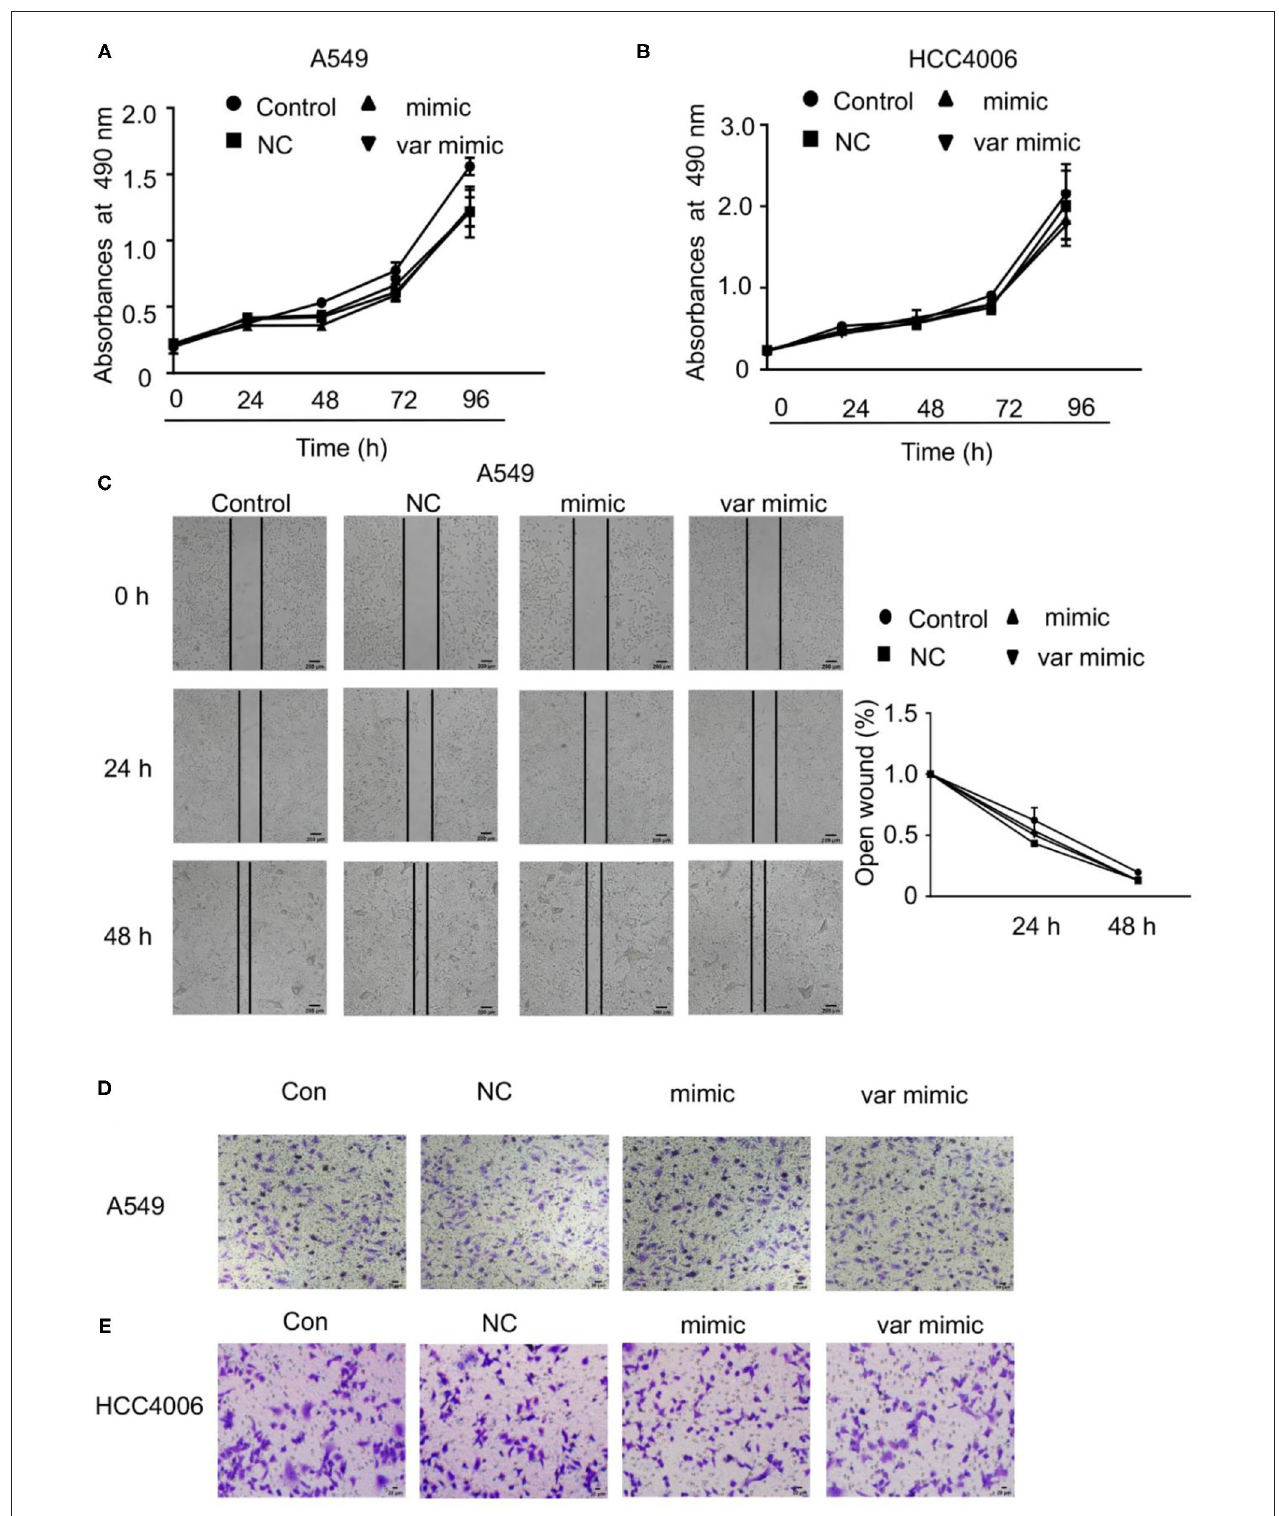
FIGURE 5 | Effect of miR-608 on the proliferation and metastasis of NSCLC cells. Cell proliferation was examined by MTT assay in A549 (A) and HCC4006 (B) cells transfected with miR-608 mimic or var mimic for the indicated times. (C) The effect of miR-608 on metastasis determined by wound-healing assay in A549 cells. Transwell assay results showing the effect of miR-608 on metastasis in A549 cells (D) and HCC4006 (E) cells. miR, microRNA.